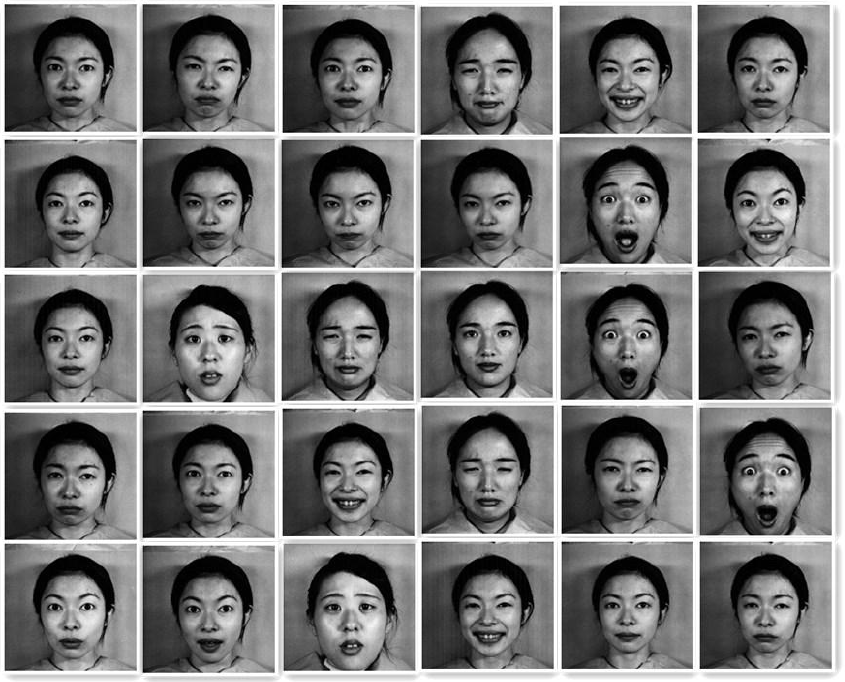
Figure 3. ( a ) two eyes location on the original image ( b ) the cropped image of 110×150 pixels from the original